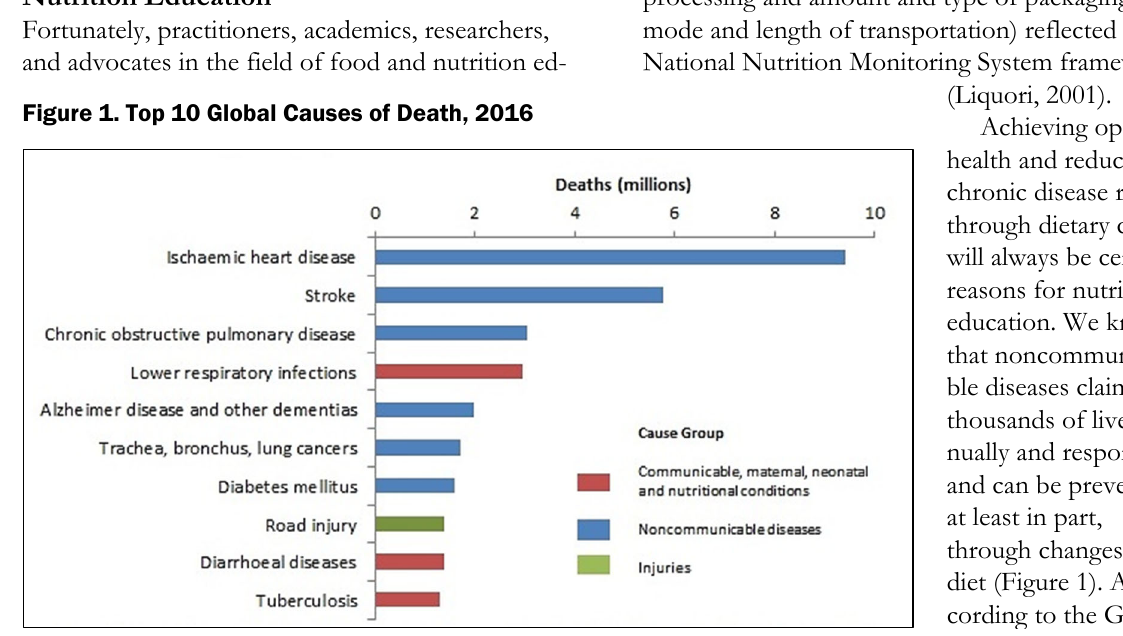
Source: World Health Organization,